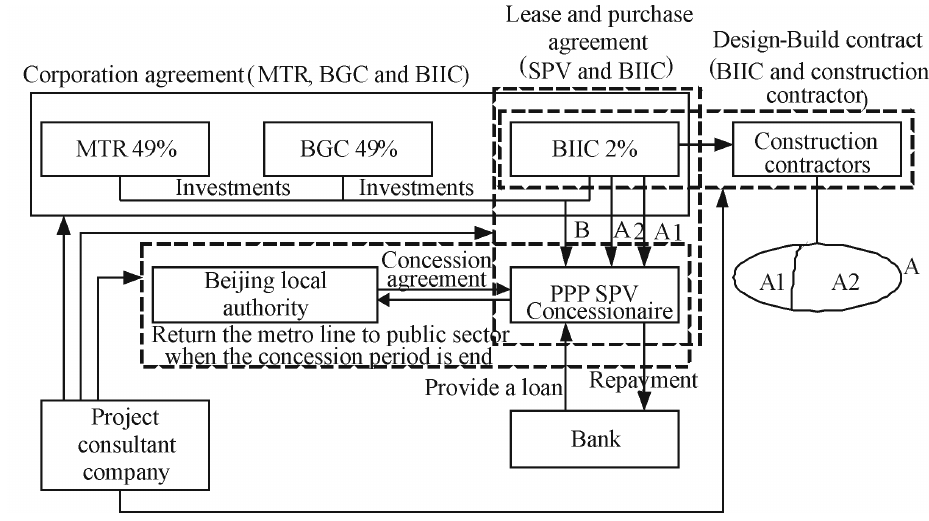
Fig. 2. The capital structure of the 4th Beijing metro line